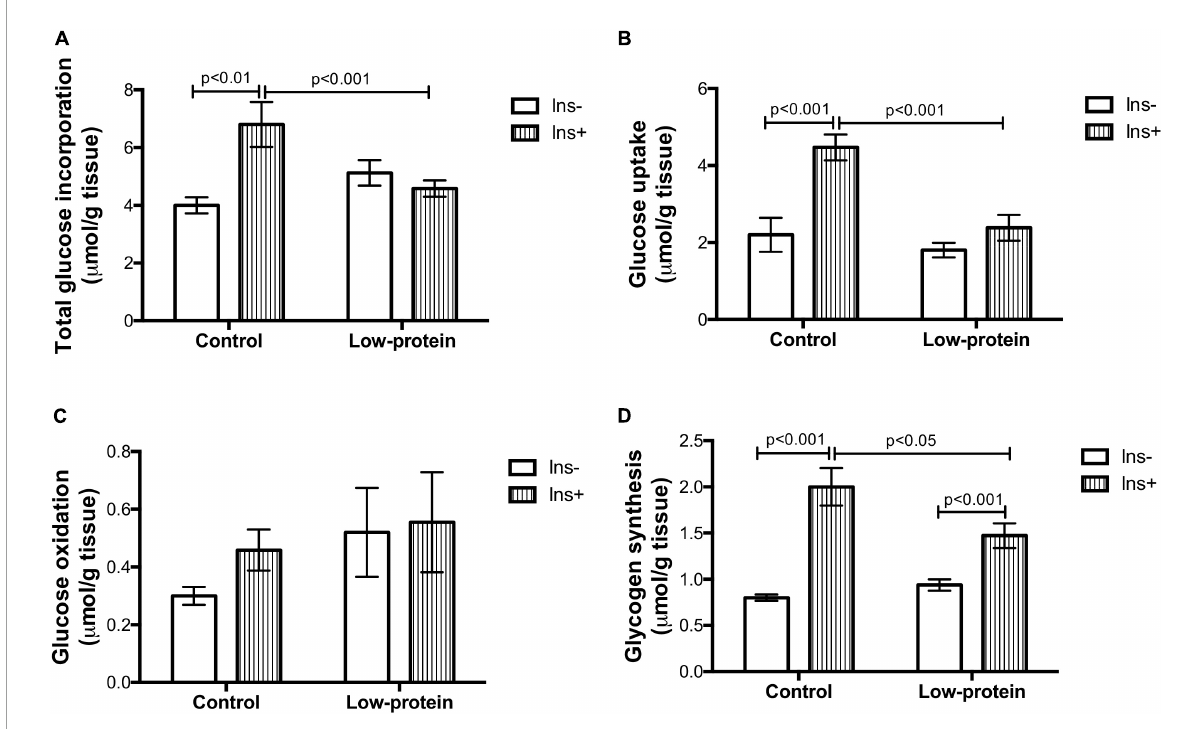
FIGURE4 Long-term effects of low-protein diet during early life on glucose metabolism in soleus muscle isolated from rats. (A) Total glucose incorporation, (B) glucose uptake, (C) glucose oxidation, and (D) glycogen synthesis in isolated soleus muscle with or without insulin in 7-month-old pups born to mothers fed a normoproteic (Control, n = 6–8) or low-protein (LP, n = 6–8) diet during pregnancy and lactation. Results analyzed using two-way ANOVA followed by Bonferroni post-test. Values expressed as mean ±